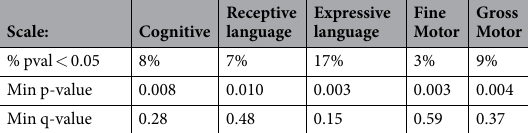
Table 2. Results of single metabolite analyses.